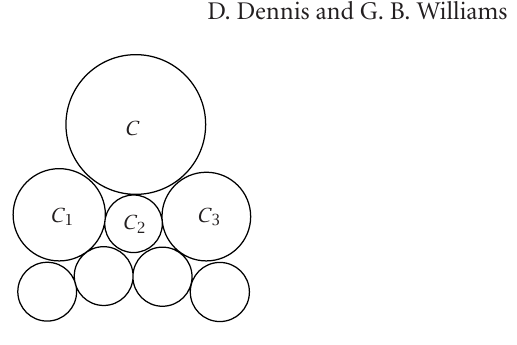
Figure 2.2. The circle C has three consecutive neighbors C 1 , C 2 , and C 3 in the previous layer. If C 2 has order at most 2, then it can have degree at most 5.